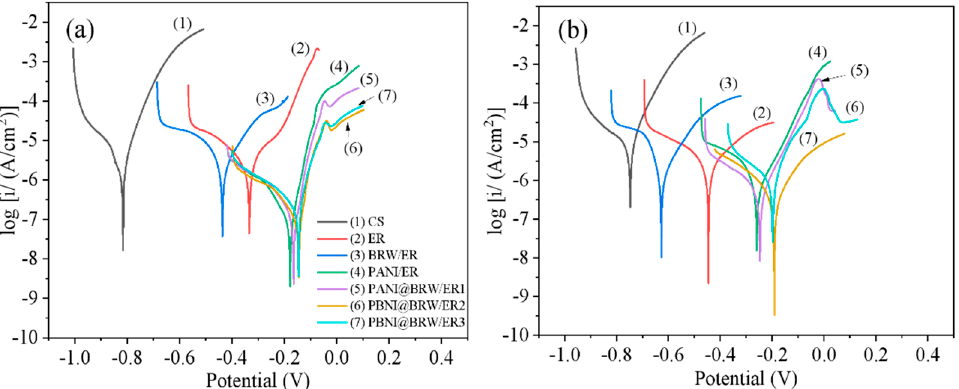
Figure 10. Tafel polarization curve for the coatings before ( a ) and after ( b ) immersion. Table 1. The corrosion current density ( i corr ), corrosion potential ( E corr ), and protection efficiency ( PE ) of different coatings. Sample